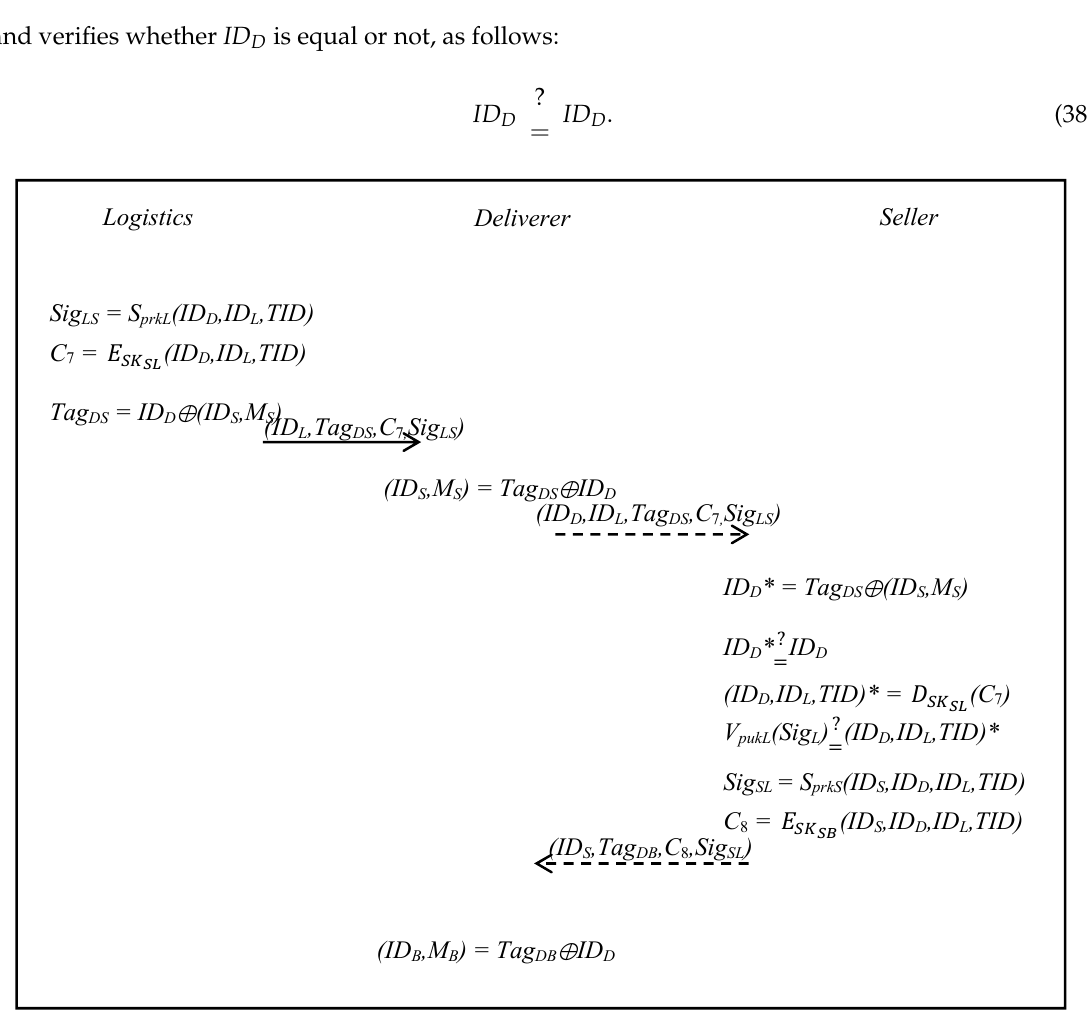
Figure 3. Package collection phase of the proposed scheme.